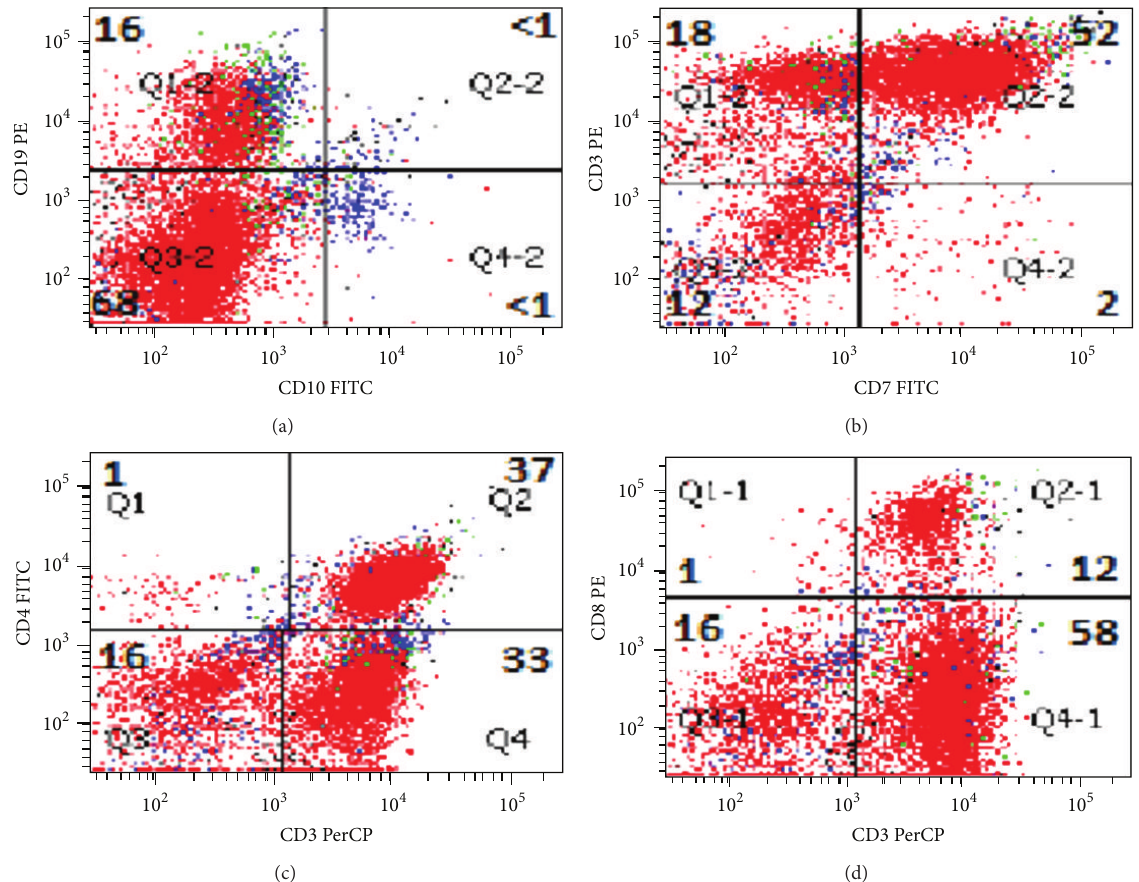
Figure 3: Flow cytometry demonstrating aberrant T cells expressing CD3 and CD19, weak CD7, and absent CD4, CD8, and CD10